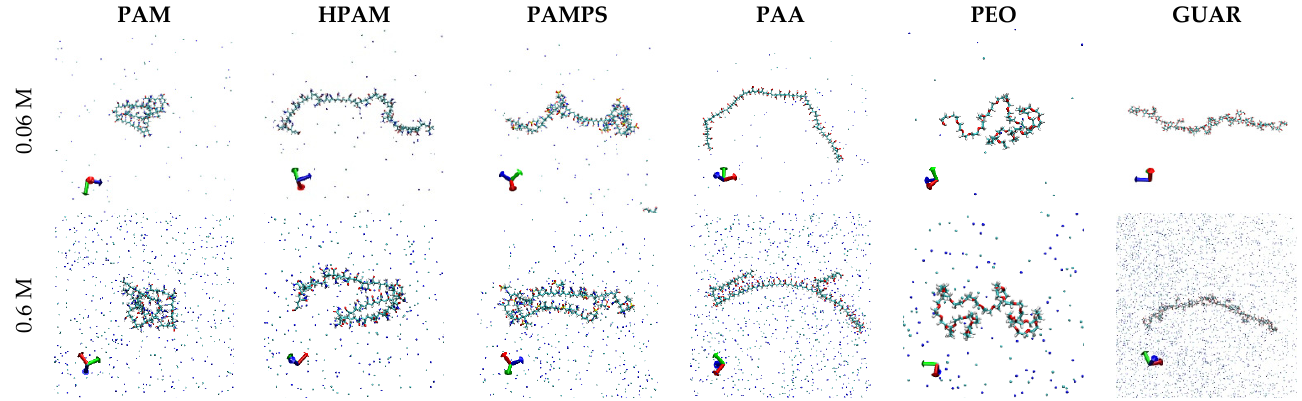
Figure 3. Snapshot of polymer configuration obtained from the simulation at 0.06 and 0.6 M for the six polymers studies.